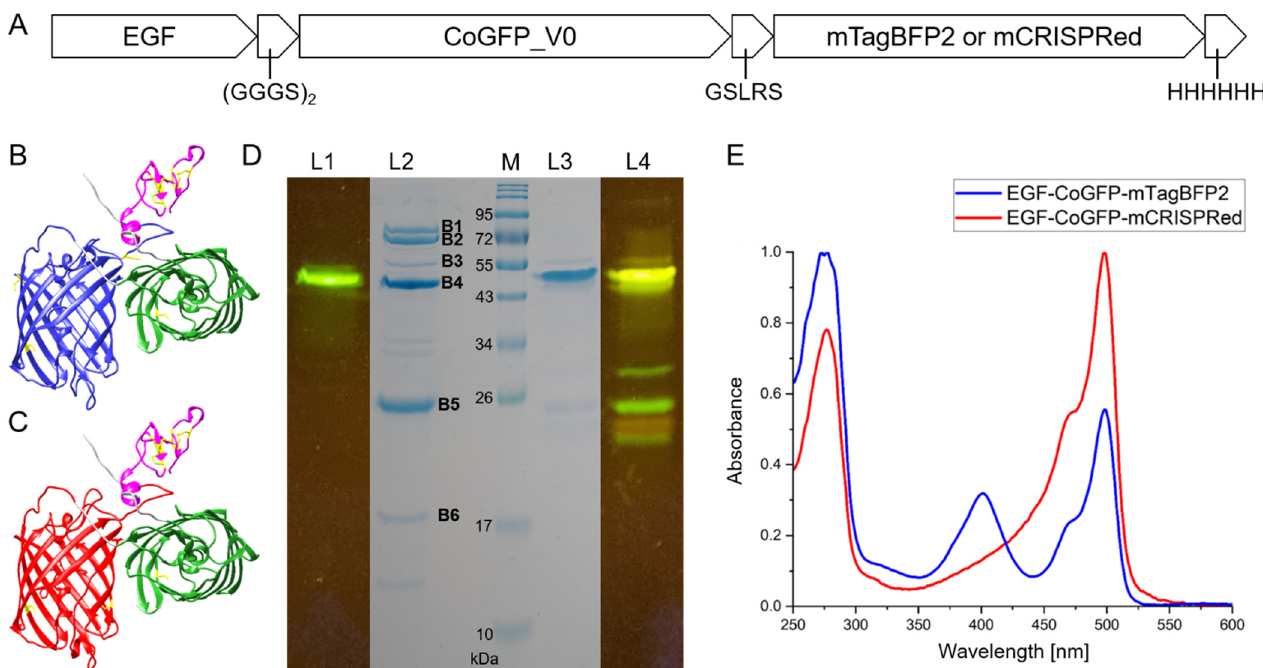
Figure 1. Model and initial characterization of ligand–tandem fluorescent proteins. ( A ) Linear scheme of pH sensor fusion proteins containing EGF, a (GGGS) 2 linker, CoGFP_V0, a five-amino-acid linker GSLRS, mTagBFP2 or mCRISPRed, and a C-terminal His 6 -tag. ( B ) Structural model of